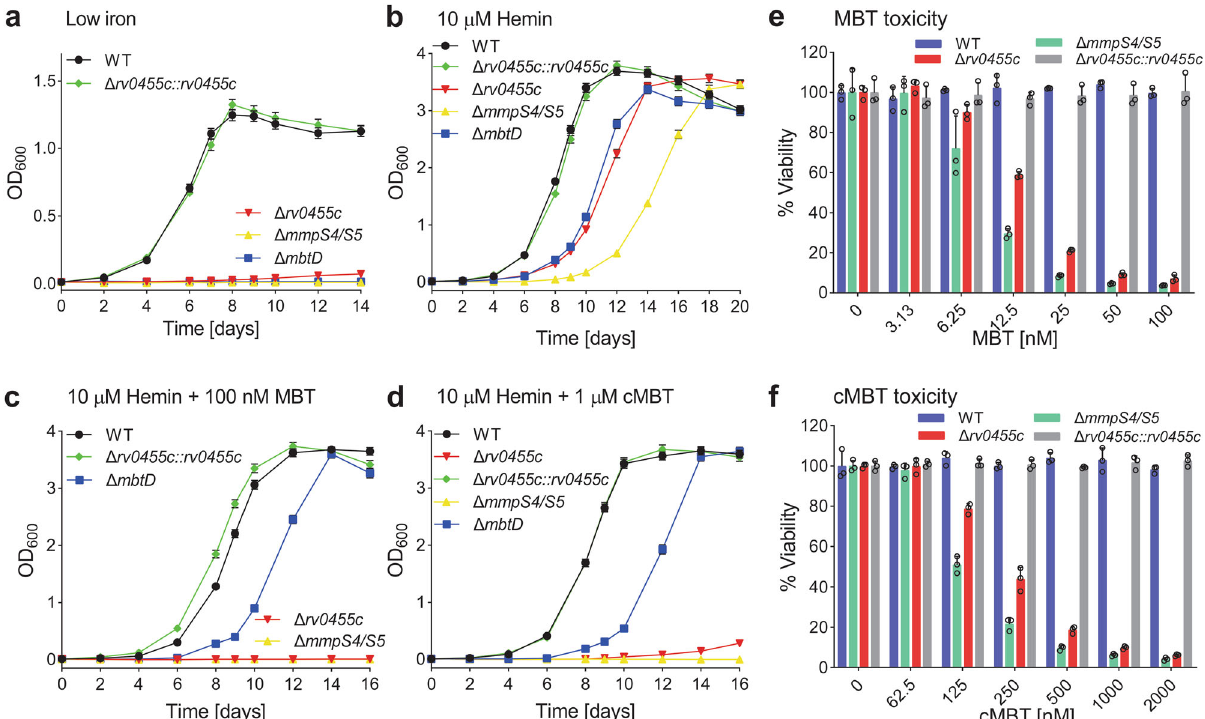
Fig. 1 The M. tuberculosis Δ rv0455c mutant is hypersensitive to exogenous siderophores. a – d The indicated M. tuberculosis strains were grown in low- iron 7H9 medium for 5 days to deplete intracellular iron before the growth assays. The initial OD 600 of all cultures was 0.01. Growth curves of M. tuberculosis mc 2 6230 (wt), Δ rv0455c ( M. tuberculosis ML2203), Δ rv0455c::rv0455c ( M. tuberculosis ML2205), Δ mmpS4/S5 ( M. tuberculosis ML859) and Δ mbtD ( M. tuberculosis ML1600) in ( a ) self-made low-iron (<0.1 μ M Fe 3 + ) 7H9 medium supplemented with ( b ) 10 μ M hemin, ( c ) 10 μ M hemin plus 100 nM Fe-mycobactin (Fe- MBT ), and ( d ) 10 μ M hemin plus 1 μ M Fe-carboxymycobactin (Fe-cMBT), respectively. Error bars represent standard deviations from the mean results of biological triplicates ( n = 3). e , f The viability of M. tuberculosis wt, Δ mmpS4/S5 , Δ rv0455c , or Δ rv0455c::rv0455c was measured using the Microplate alamarBlue assay. Cells treated with increasing concentrations of ( e ) Fe-mycobactin (Fe- MBT ) or ( f ) Fe-carboxymycobactin (Fe- cMBT). Cells were grown in 7H9 medium supplemented with 20 μ M hemin. Error bars represent standard deviations from the mean values of biological triplicates ( n = 3). Source data are provided in the Source Data fi